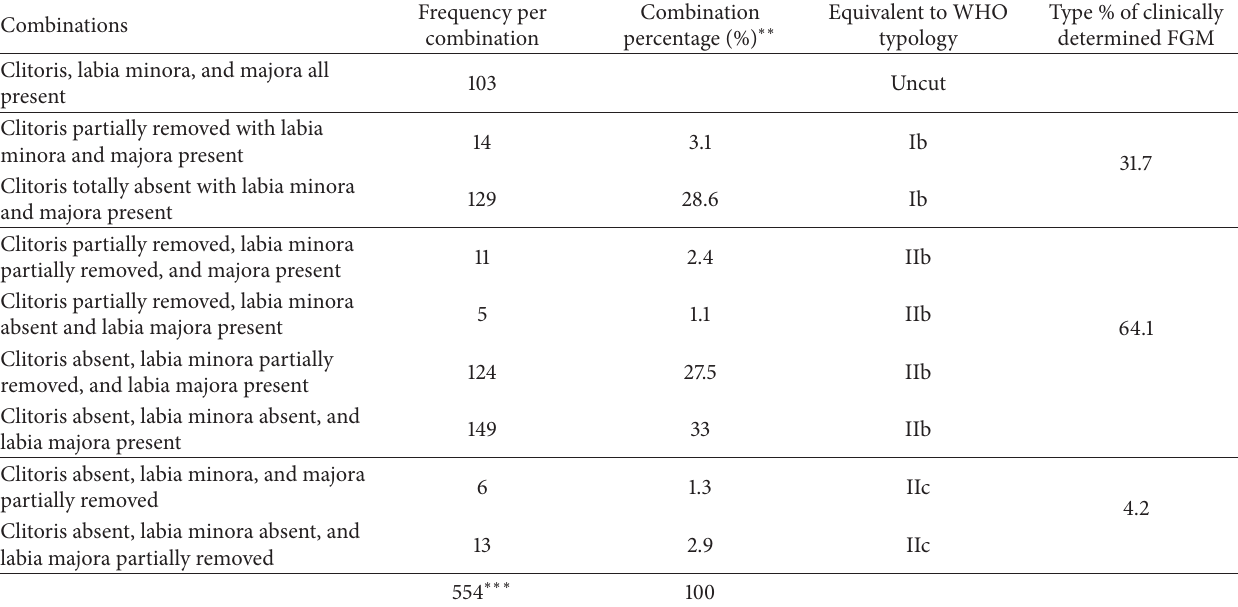
Table 4: Forms and type of FGM derived from observed anatomical description of clitoris, labia minora and labia majora.